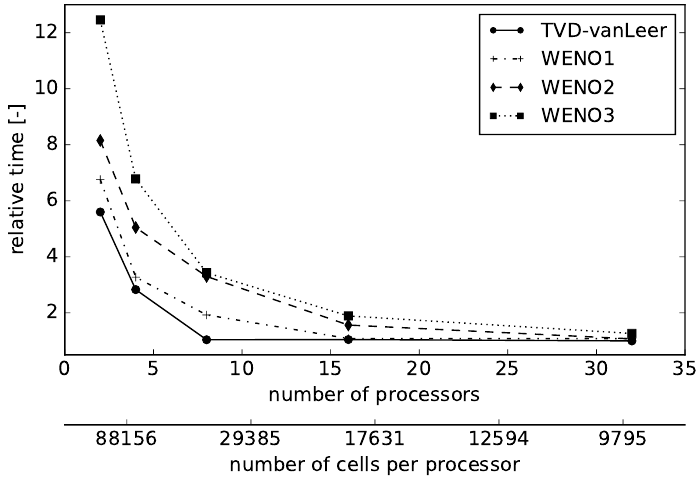
Figure 24. Time for one discretisation step related to TVD-vanLeer on 32 processors using different schemes and number of processors. All computations are executed using the interFoam solver.